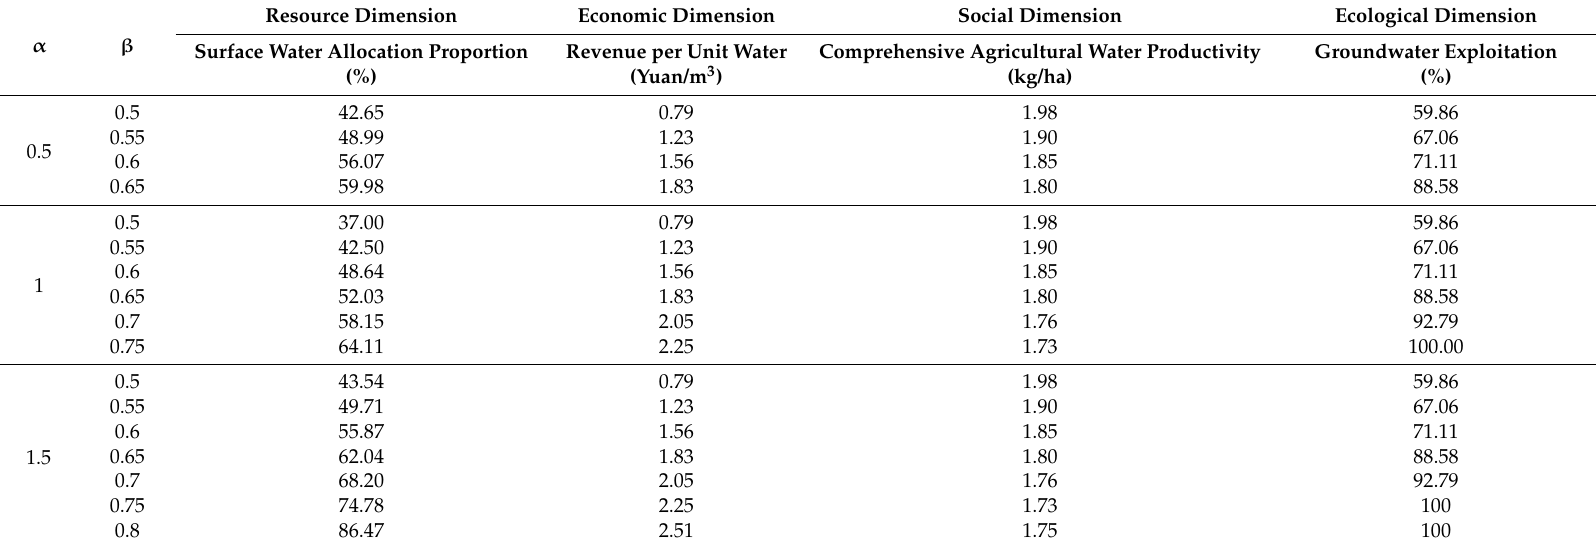
Table 4. Key indicators for multi-dimensional regulation under different